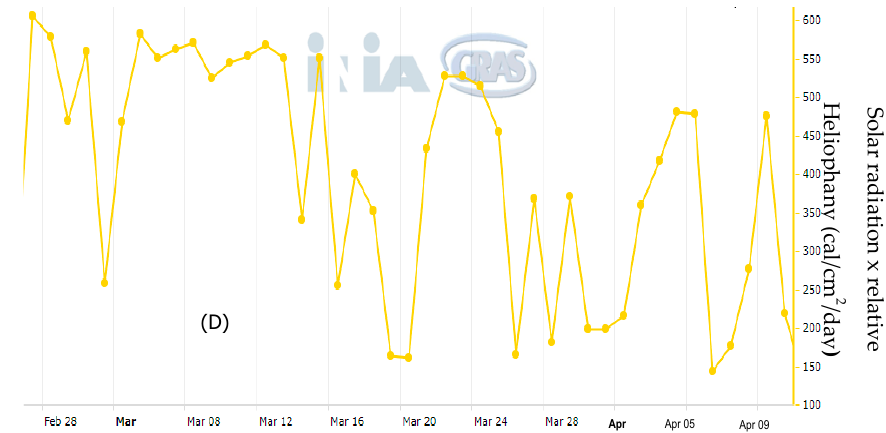
Figure 1. Maximum, average and minimum daily temperature ( A ), precipitation ( B ), relative humidity ( C ) and solar radiation x relative Heliofania ( D ).